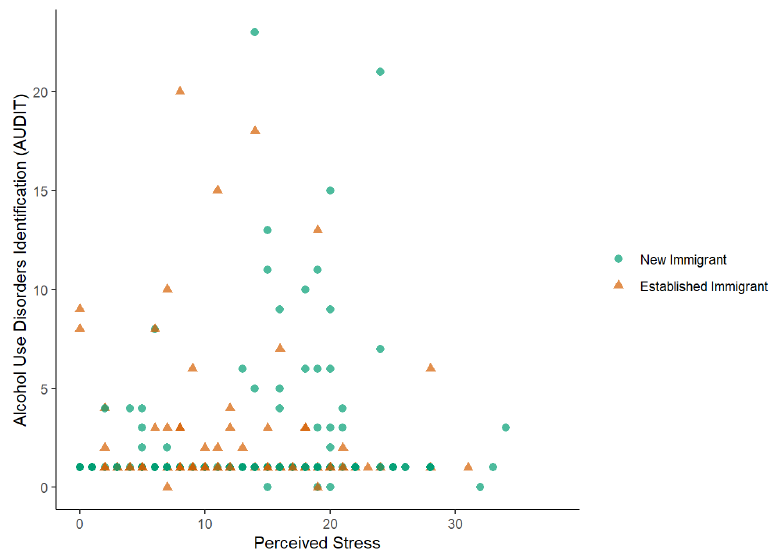
Figure 1. Correlation Plot across AUDIT Scores vs. Perceived Stress Scores, for New and Established Immigrants.